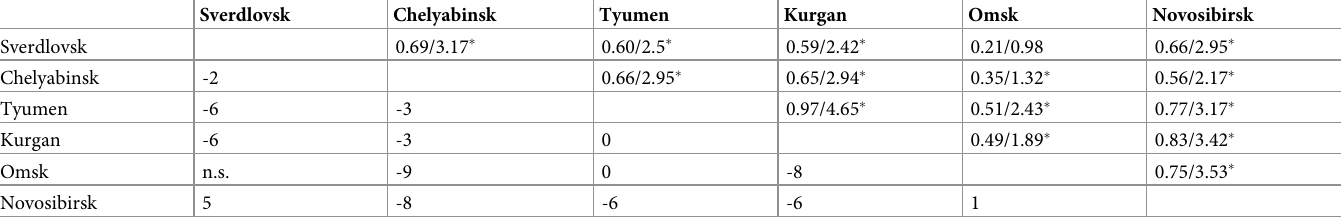
Table 3. The characteristics of cross-correlation functions between defoliated areas of studied oblasts of the Russian Federation; the values of function/t-value are above the main diagonal and the temporal delays (k, years) are